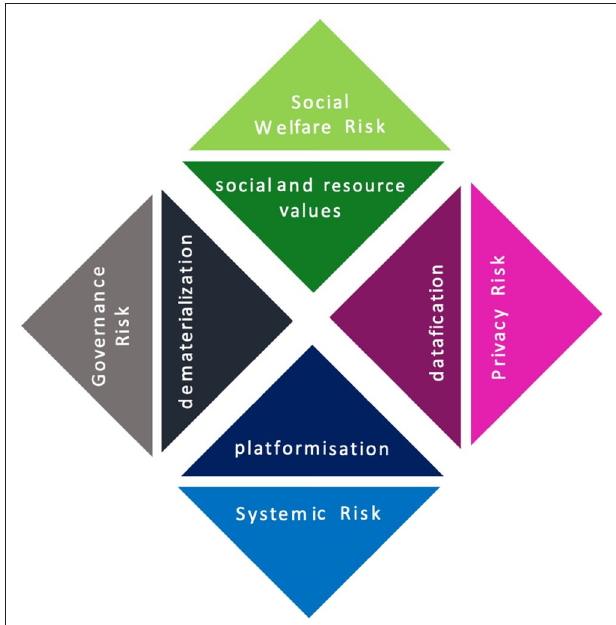
FIGURE 1 | Four megatrends underpinning the Internet of Value and four major sources of